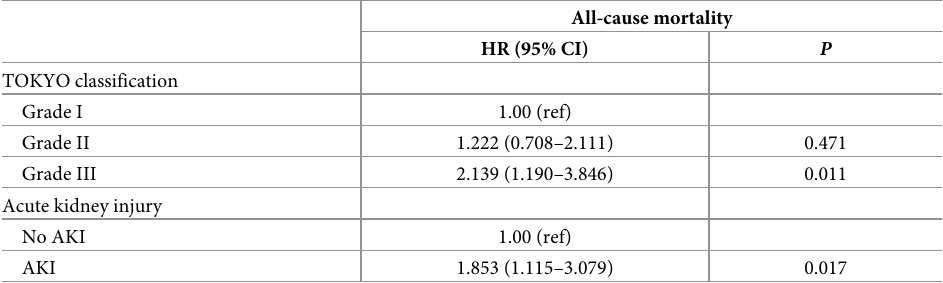
The association between obstructive jaundice and acute renal failure (ARF) is well-recog- nized; ARF may develop in patients with jaundice caused either by operation or septicemia (or both), but is rarely described [25]. Bismuth et al. (1975) reported an association between AC Table 4. Hazard ratios for all-cause mortality risk factors in Acute cholangitis patients.